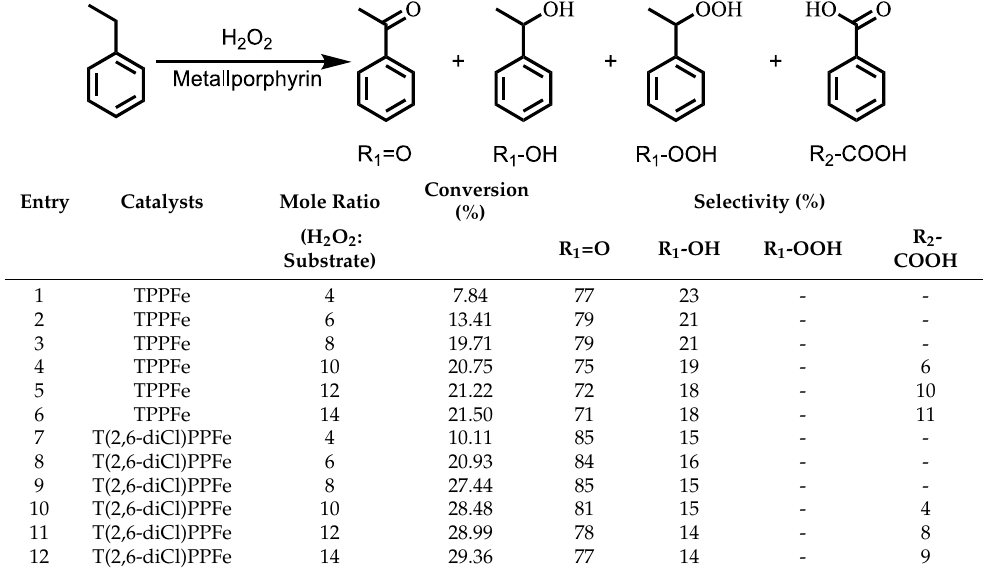
Table 5. E ff ect of oxidant amount on alkyl aromatics oxygenation employing ethylbenzene as model substrate a .